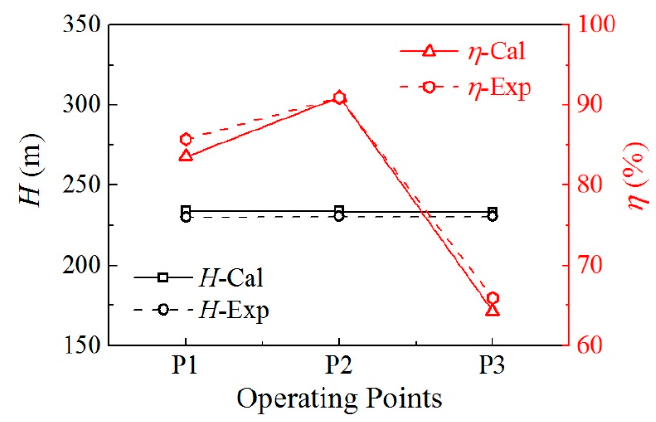
Figure 6. Comparison of performance characteristics between experiments and numerical simulation.